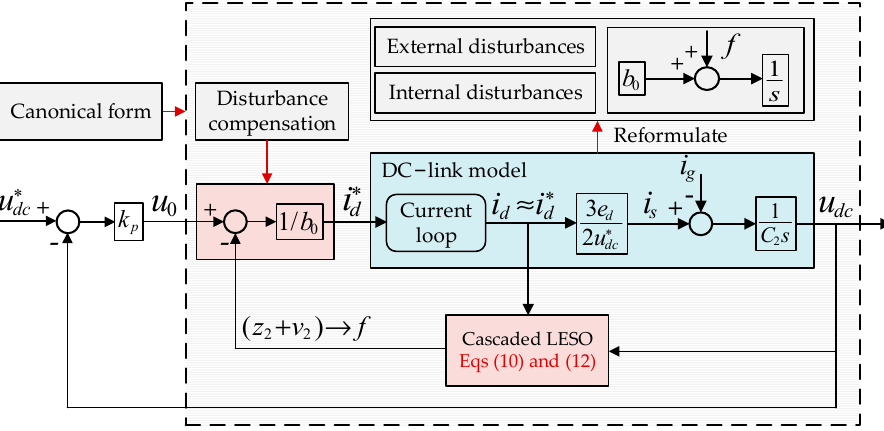
Figure 5. The voltage loop control block diagram based on modified LADRC, in which the dc link plant with complex nonlinear characteristics is compensated as a canonical first-order pure inte- gral.